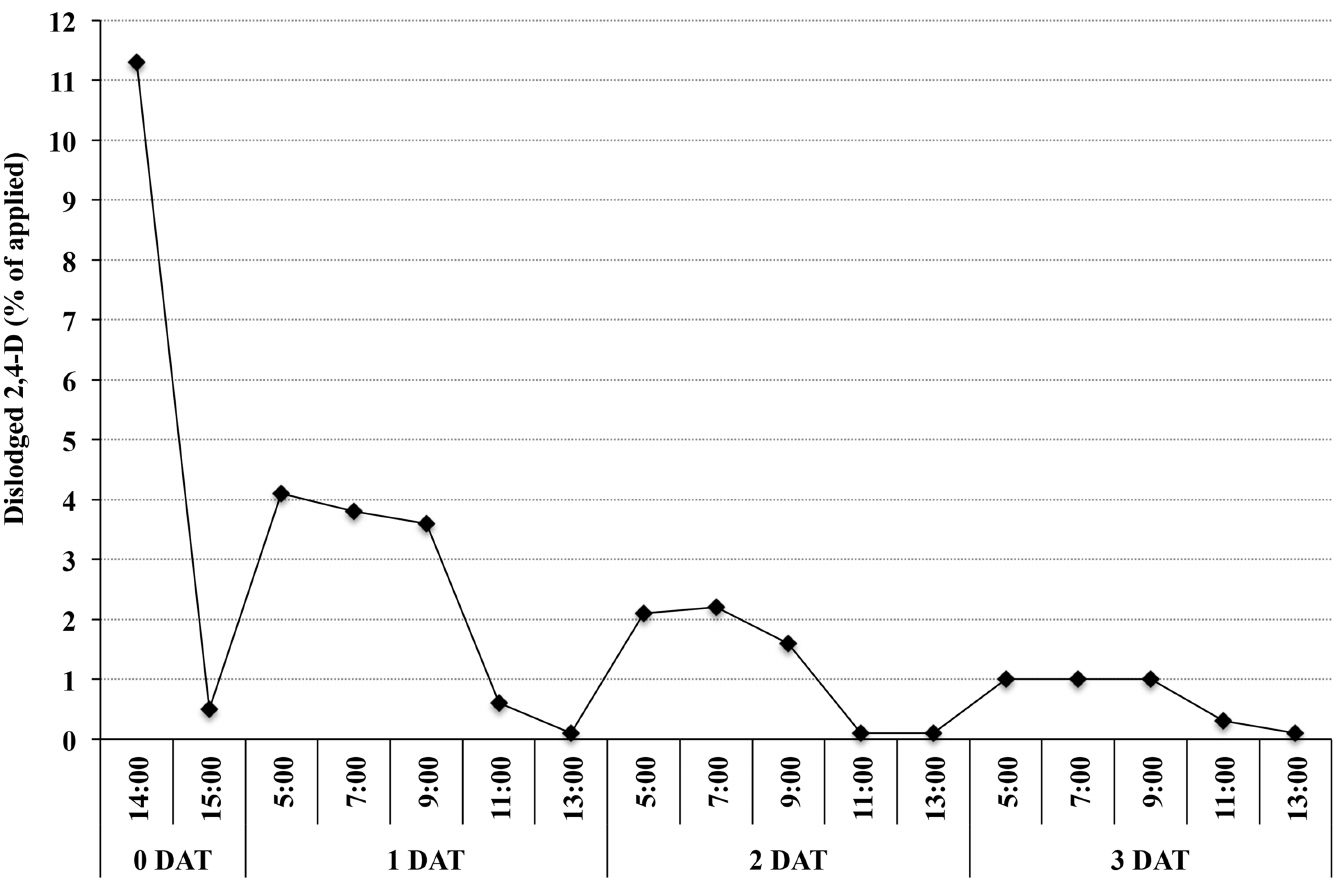
Fig 1. Dislodgeable 2,4-D residues fluctuate over time. Percent dislodged following one soccer ball roll (3.7 m) from hybrid bermudagrass of the applied (2.1 kg 2,4-D ha -1 ) at 14:00 (immediate) and 15:00 on 0 d after treatment (DAT), and from 5:00 to 13:00, 1 to 3 DAT. All sample collection times were eastern standard